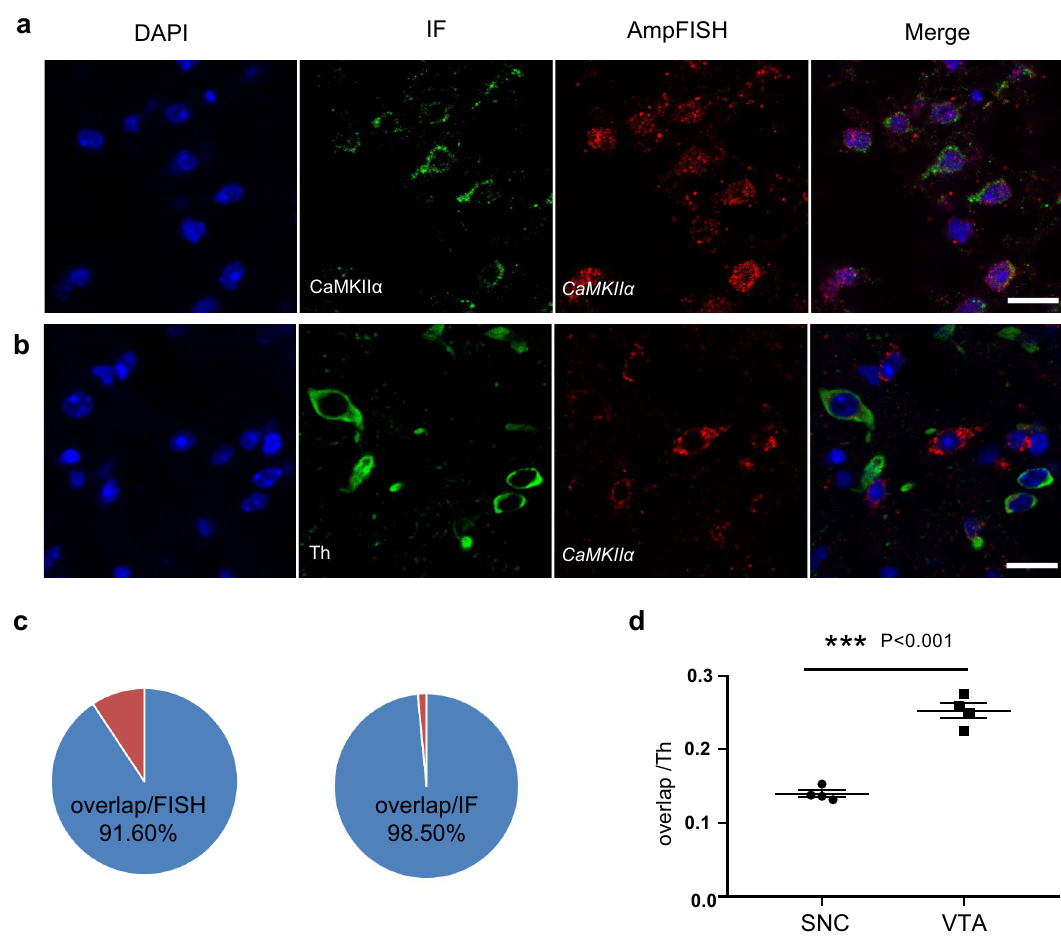
Fig. 5 AmpFISH assay in combination with IF. a IF and AmpFISH assays were veri fi ed mutually. IF for CaMKII α protein and AmpFISH for CaMKII α mRNA were double-labeled in the same slice from the CPu brain region (scale bar: 20 μ m). b The TH + CaMKII α + cell subtypes were detected in the slice from the VTA brain region through a combination of IF with AmpFISH (scale bar: 20 μ m). c The proportion of positive double-labeled cells was analyzed. “ Overlap ” represents cells with both IF-and AmpFISH-positive signals. Overlap/FISH represents the proportion of overlapping cells with a positive AmpFISH signal (91.68 ± 2.07%, n = 5). In the same way, Overlap/FISH represents the proportion of overlapping cells with a positive IF signal (98.50 ± 1.14%, n = 5). The total number of “ overlap ” cells, cells with AmpFISH signal, and cells with IF signal were 170, 185, and 172, respectively, from fi ve different brain slices. d Statistical analysis and comparison of cell populations in the SNC and VTA brain slices. The proportion of Th + /CaMKII α + cells ( “ overlap ” ) accounting for T + cells in the VTA area (25.27 ± 0.46%) is signi fi cantly higher than that in the SNC area (13.97 ± 1.04%) ( n = 4) (unpaired t -test with Welch ’ s correction, two-tailed, P <